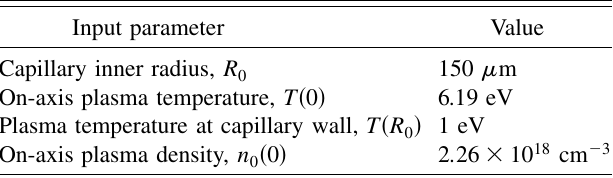
TABLE I. Input parameters used in quasistatic model for com- parison with Bobrova model